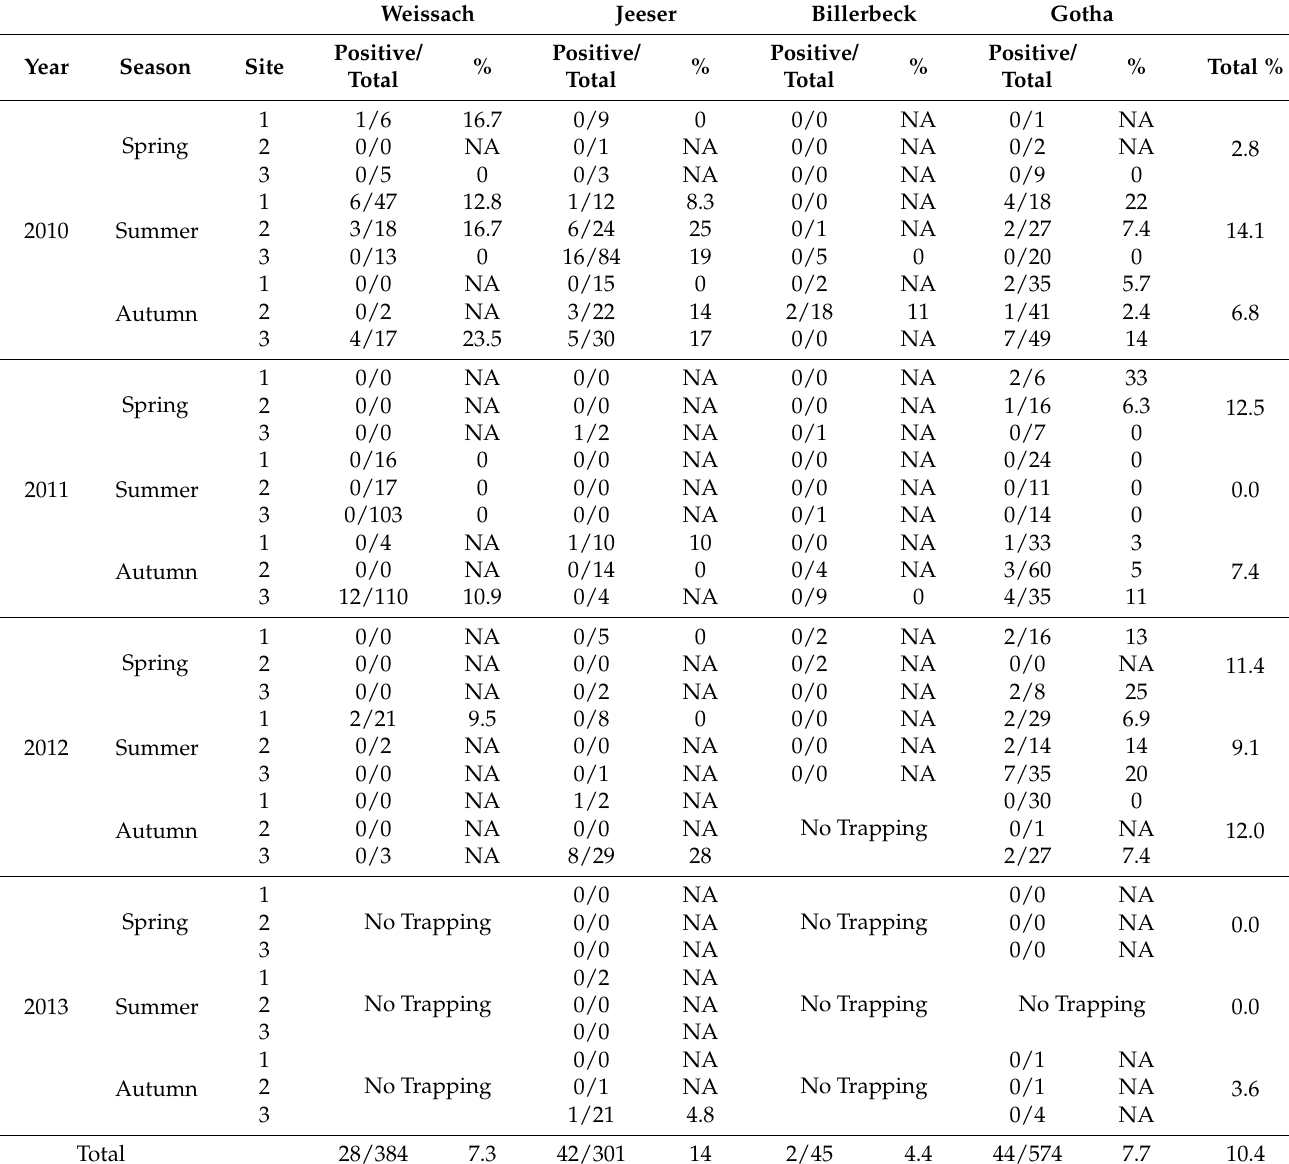
Table 1. TULV seroprevalence in common vole populations in four German areas from 2010 to 2013. Seroprevalence (%) in spring, summer and autumn of each year was estimated for three replicate grassland sites per area based on live and snap trapping. Values for the number of positive tested individuals (positive/total) per season are given for all sites in each study area. Percentages were calculated only for sites with ≥ 5 tested individuals (otherwise NA = not applicable).